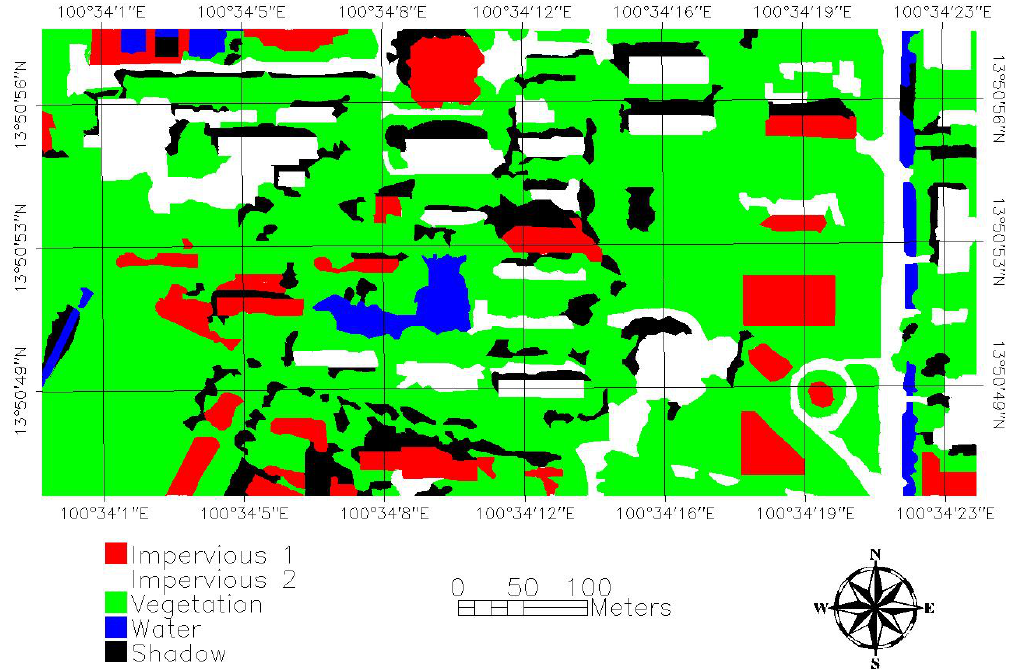
Figure 10. Ground truth image for Example 2 (green, blue, black, red and white colors for vegetation, water, shadow, impervious type 1 and impervious type 2,